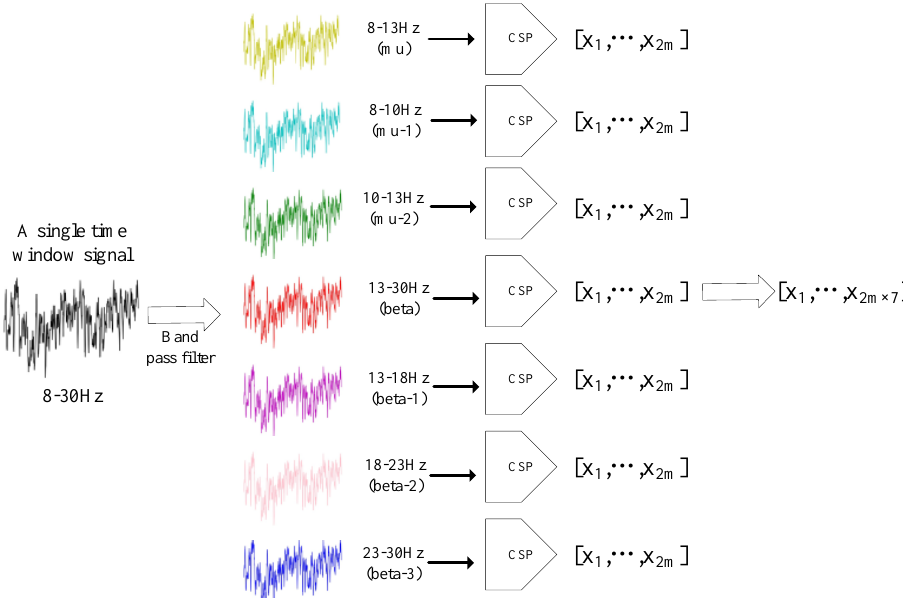
Figure 3. Multi – band features fusion based on CSP.